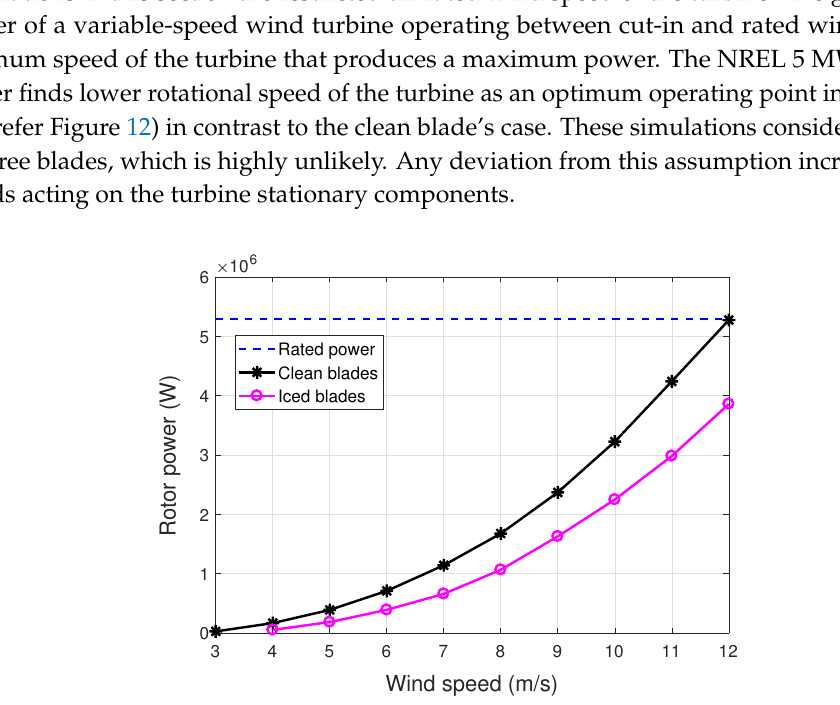
Figure 11. Comparison of the turbine’s mechanical power output simulated with clean and iced blades.